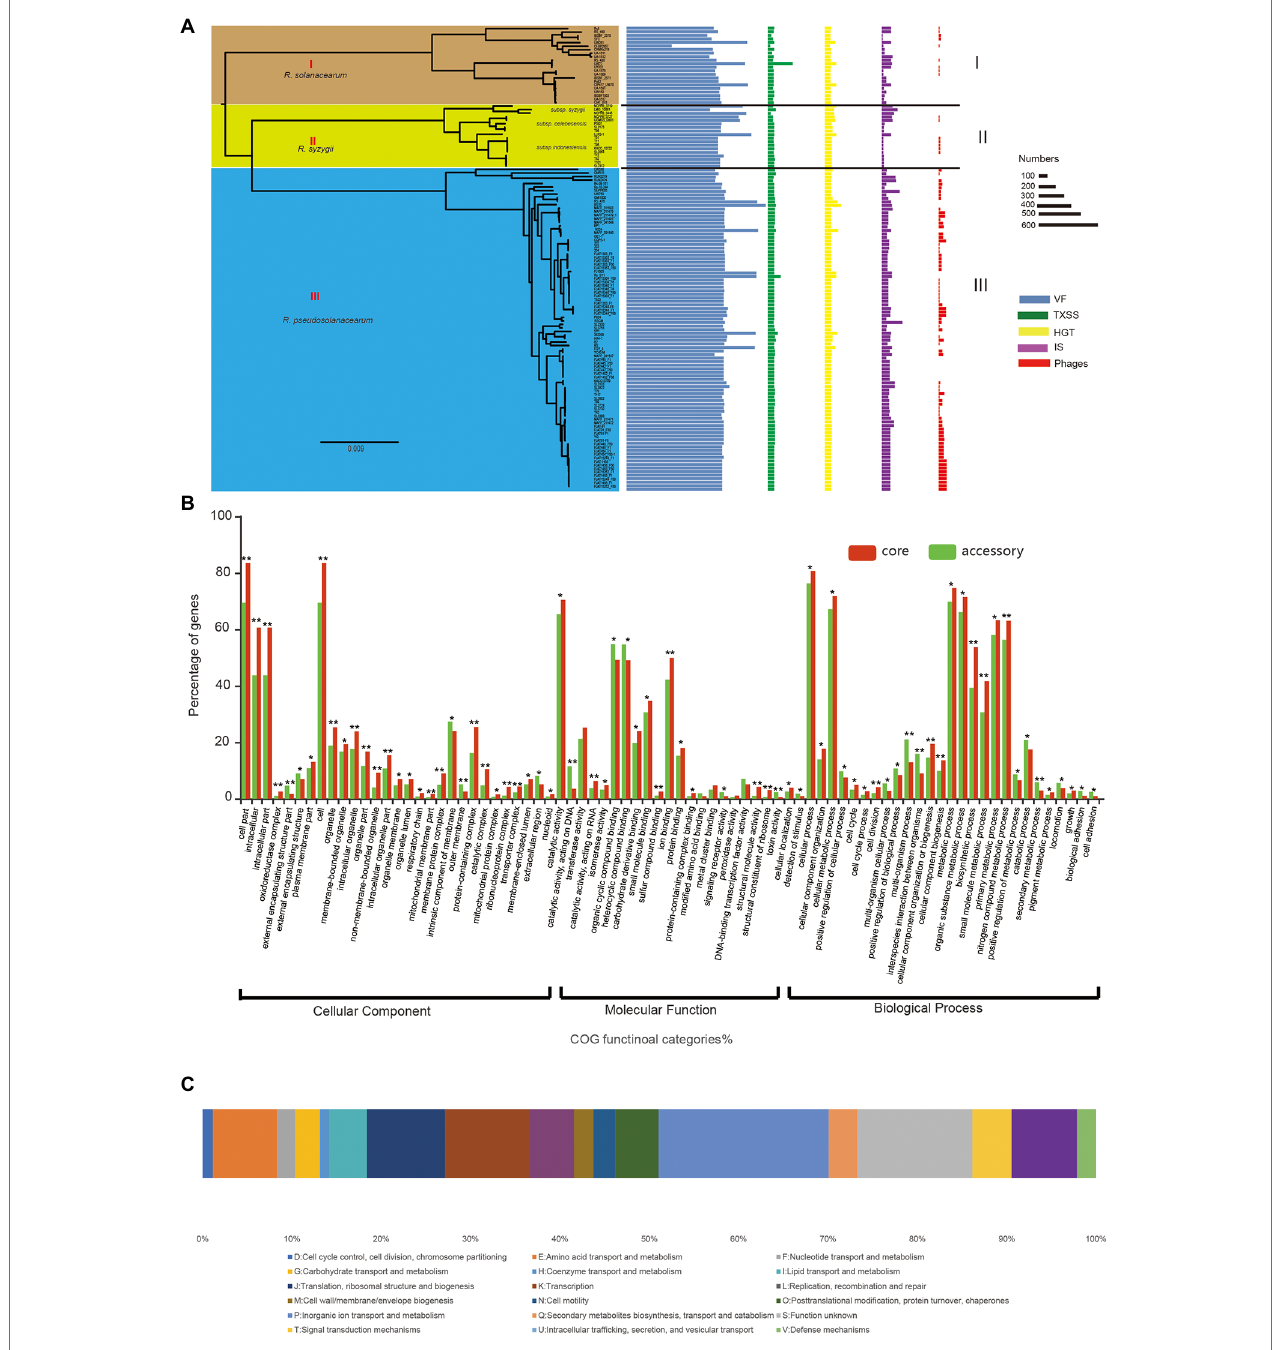
FIGURE 4 | The pathogenicity and evolution of RSSC. (A) Distribution of virulence factor (VF), TXSS, horizontal gene transfer (HGT), insertion sequence (IS), and Phages in each strain of RSSC. The different groups were associated with that in the core genome tree ( Figure 3A ). (B) Distribution of GO functions in the core genome (red) and accessory genome (green). * t test p < 0.05; ** t test p < 0.01. (C) Distribution of clusters of orthologous groups of proteins (COG) categories for HGT gene